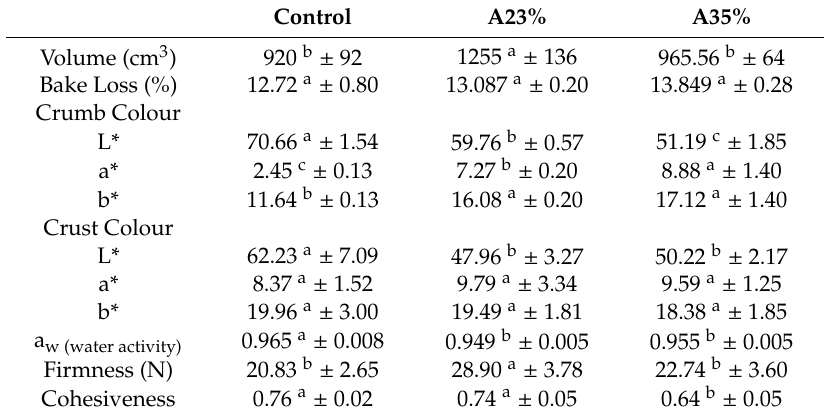
Table 1. Physical characteristics of the gluten-free bread (GFB) with the incorporation of di ff erent ratios of acorn flour (A23% and A35%) and comparison with the control